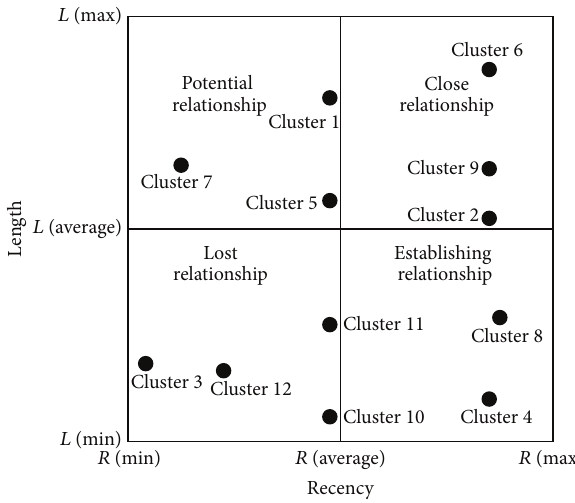
Figure 5: Twelve clusters in customer relationship